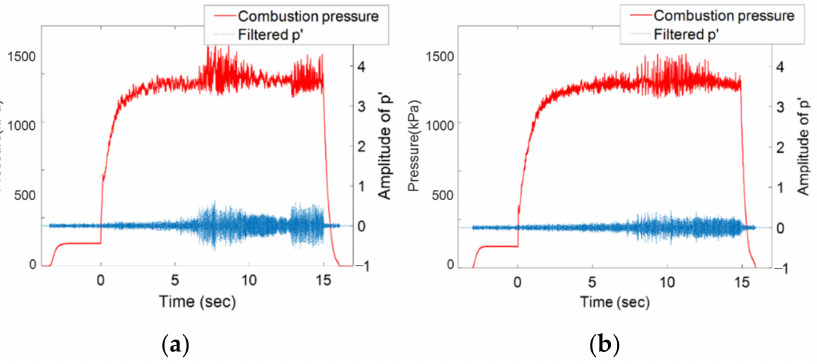
Figure 4. Combustion pressure and filtered pressure fluctuations p (cid:48) in ( a ) baseline and ( b ) test 1.